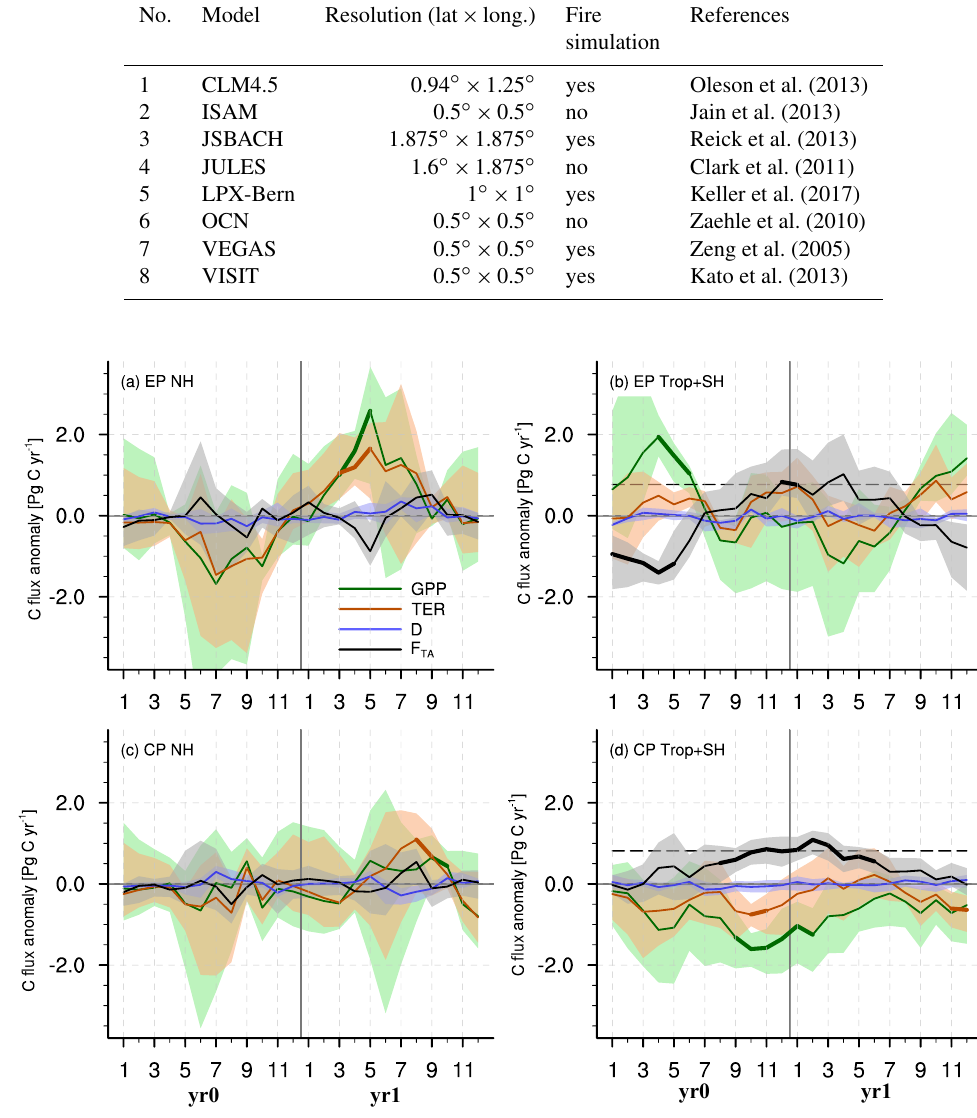
Figure 4. Composites of anomalies in the TRENDY F TA (black lines), gross primary productivity (GPP, green lines), terrestrial ecosystem respiration (TER, brown lines), and the carbon flux caused by disturbances (D, blue lines) during two types of El Niños over the extratropical Northern Hemisphere (NH, 23–90 ◦ N) and the tropics and extratropical Southern Hemisphere (Trop + SH, 60–23 ◦ S). The shaded area denotes the 95% confidence intervals of the variables in the composite, derived from 1000 bootstrap estimates. The bold lines indicate the significance above the 80% level estimated by the Student’s t test. The black dashed lines in b and d represent the thresholds of the peak